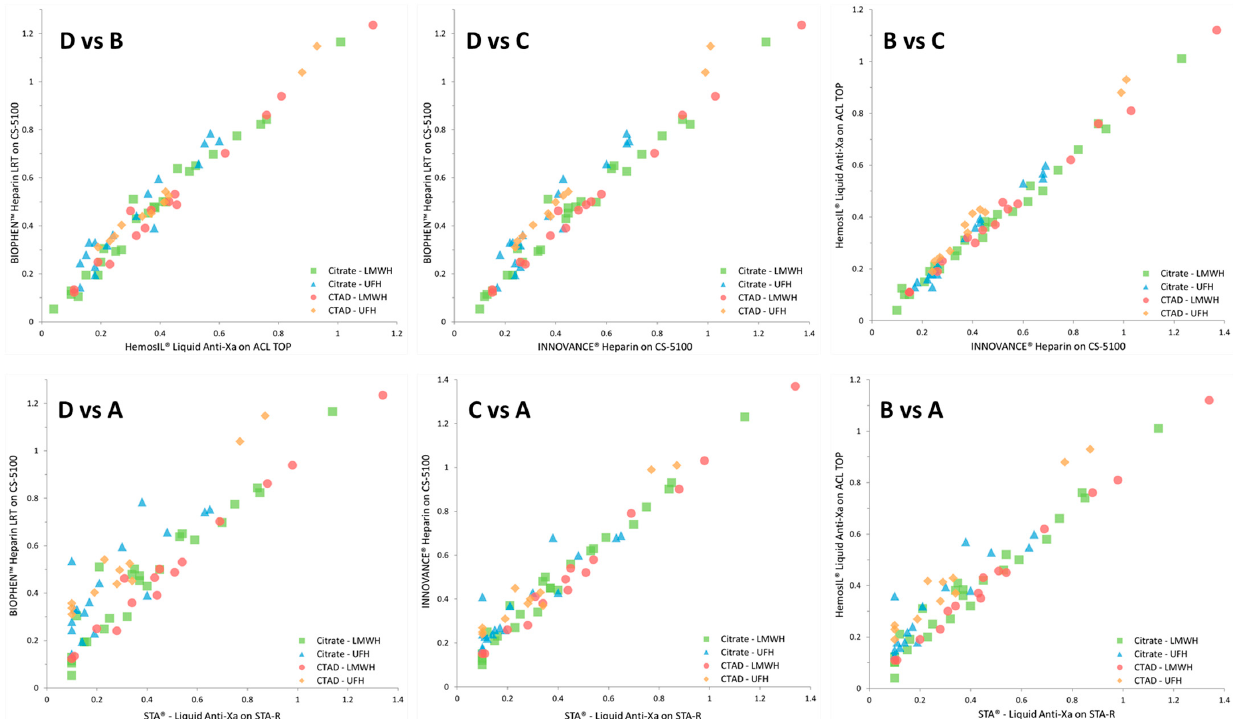
Figure 3. Pearson’s cross-correlations for the comparison of the tested subgroups (UFH-citrate, blue triangles; LMWH- citrate, green squares; UFH-CTAD, orange dots; LMWH-citrate, orange diamonds) with the different reagent-instrument combinations (i.e., reagents A, B, C, and D). Table 3. The Pearson’s correlation coefficients are shown in the tables associated with this Figure 3, for the 4